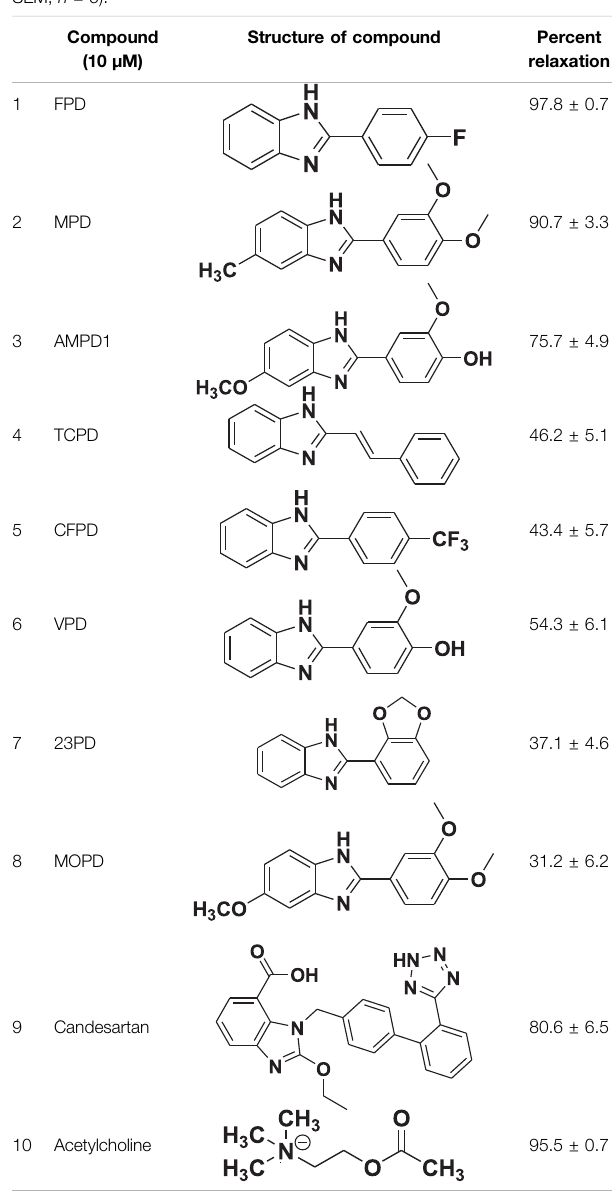
TABLE 1 | Screening of novel benzimidazole class of compounds for vasorelaxation in isolated endothelium-intact rat superior mesenteric arterial rings against U46619 (100 nM)-induced contraction. Acetylcholine (10 µM)- induced relaxation is considered as positive control for the screening (mean ± SEM, n (cid:2)